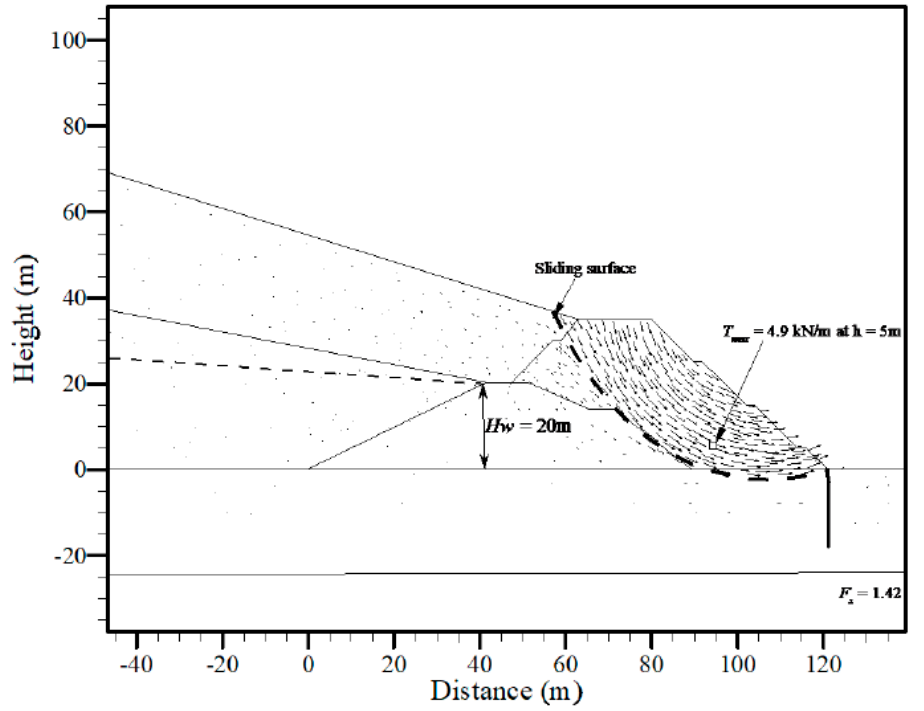
Figure 7. Numerical result of baseline under normal working conditions.